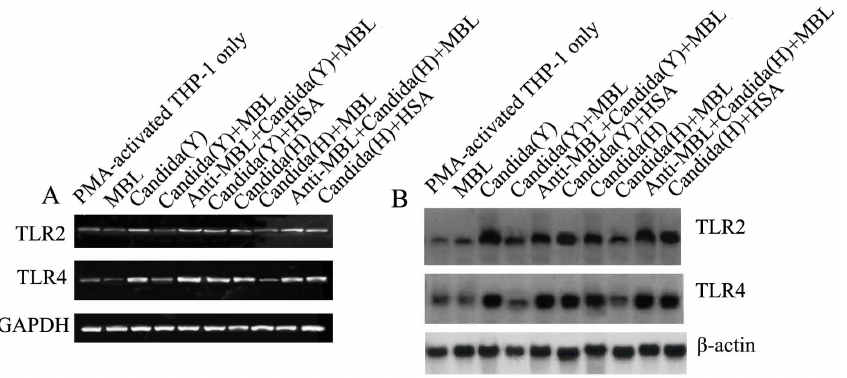
Figure 7. MBL inhibits C.albicans -induced TLR2 and TLR4 expressions in PMA-activated THP-1 cells. (A) Expression of TLR2 and TLR4 in PMA-activated THP-1 cells was analyzed by RT-PCR. Total RNA was isolated from PMA-activated THP-1 cells cultured in medium with or without HK Y or H cells of C. albicans at a Candida/THP-1 ratio of 2:1 for 2 h by using a Qiagen kit. Glyceraldehyde-3-phosphate dehydrogenase (GAPDH) was used as an internal control. (B) Northern blot analysis. Total RNA was prepared from PMA-activated THP-1 cells cultured in medium (with or without HK Y or H cells of C. albicans at a Candida/THP-1 ratio of 2:1) for 2 h, Blots were hybridized with probes specific for TLR2 or TLR4. b -actin was used as an internal control.